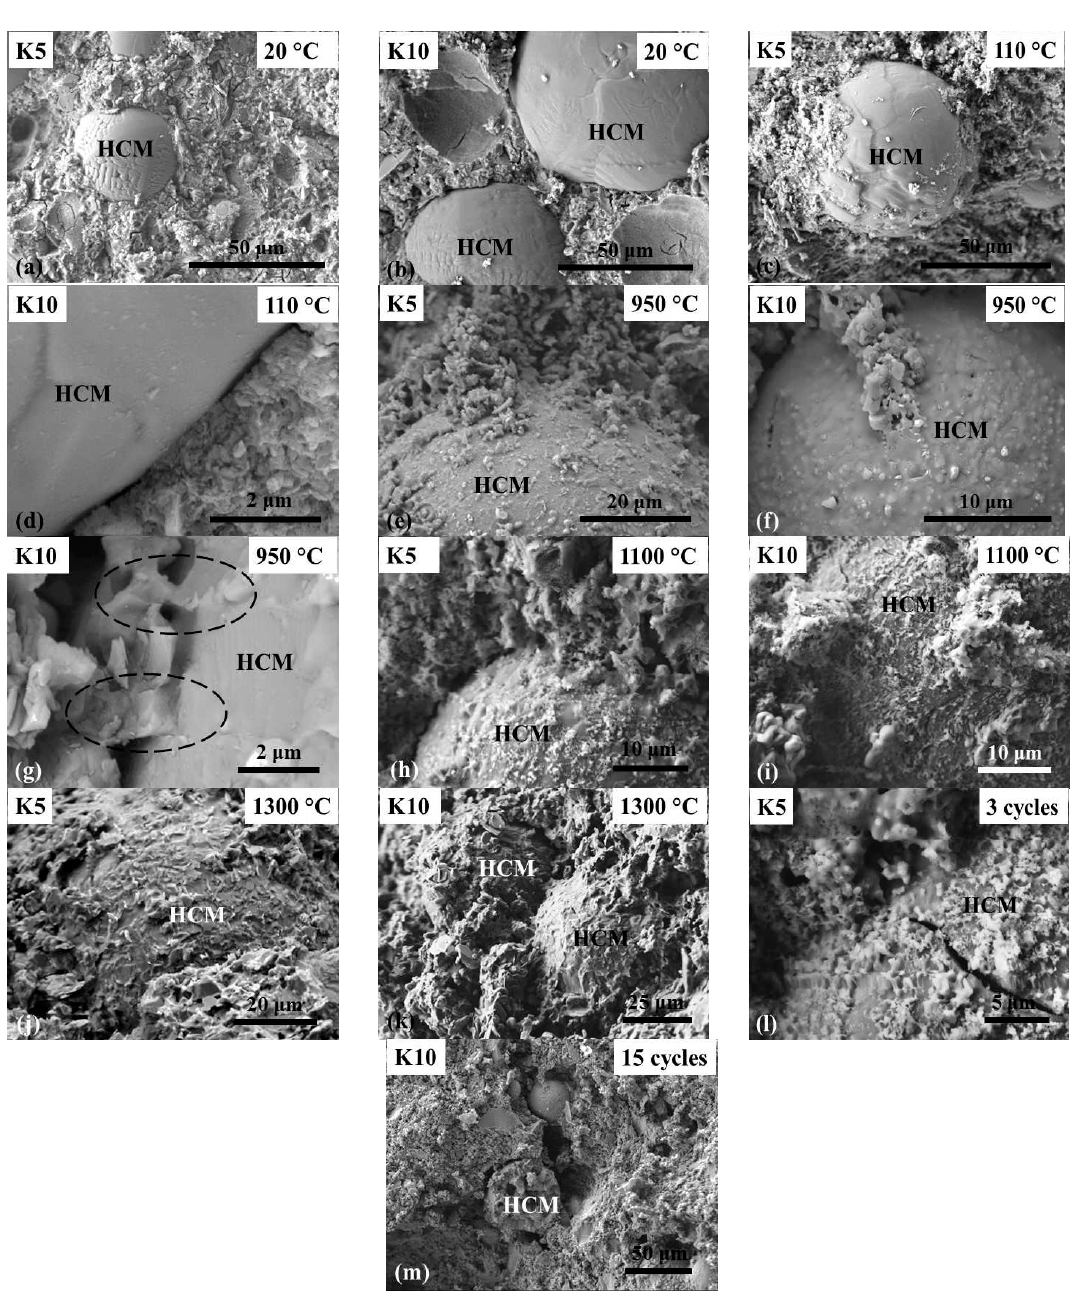
Figure 6. SEM images of the structure of castables containing 5% and 10% of HCM after hardening at 20 °C ( a , b ), drying at 110 °C ( c , d ), firing at 950 °C ( e – g ), 1100 °C ( h , i ), and 1300 °C ( j , k ), and after 3 and 15 thermal cycles ( l , m ). A higher occurrence of microsphere clusters was observed in castables containing a higher amount of HCM (10%). In this case, the matrix does not completely cover the sur ‐ face of the particle and spaces remain between the particles or a thin layer of matrix is